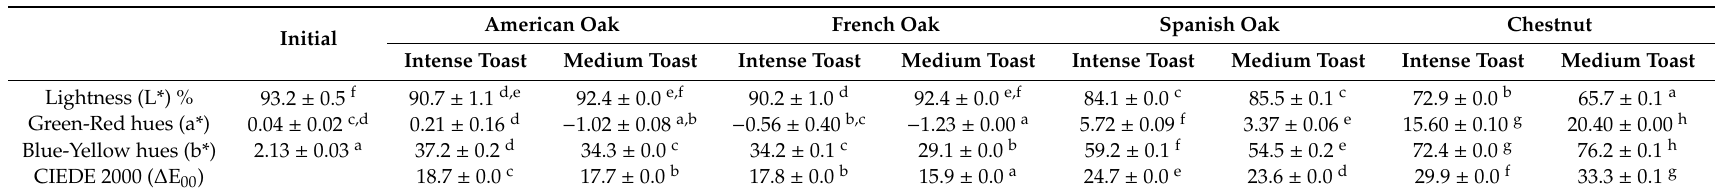
Table 3. Chromatic characteristics of distillates ageing in barrel of American, French and Spanish oak, and Chestnut. American Oak Chestnut Initial